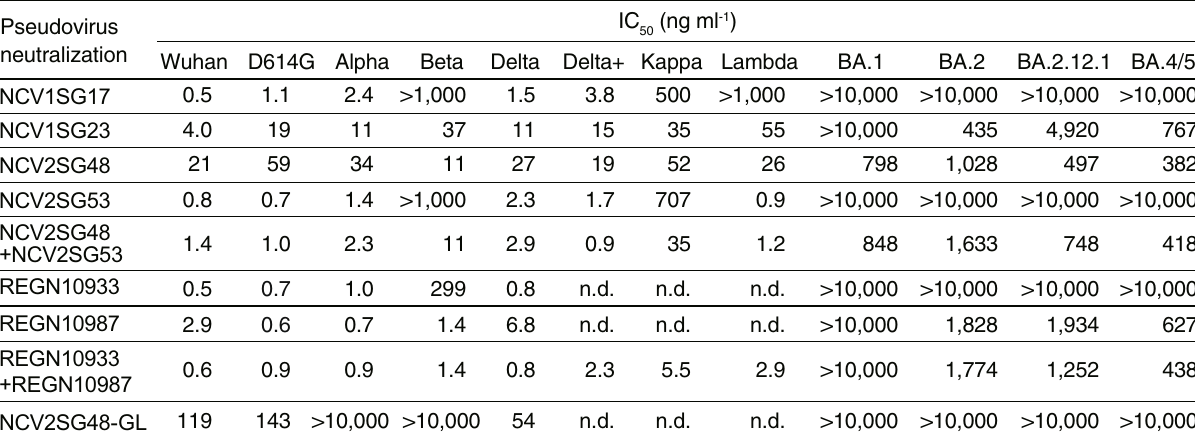
Fig. 2 Broadly neutralizing potency of mAbs against SARS-CoV-2 variants. a Dose-response analysis of the neutralization by each mAb NCV1SG17, NCV1SG23, NCV2SG48, NCV2SG53, REGN10933, and REGN10987 on indicated variants of SARS-CoV-2 pseudovirus. The horizontal dotted line on each graph indicates 50% neutralization. Data are mean ± SEM of technical replicates from 2 to 3 independent experiments. b The IC 50 neutralization values of each and the mixture of mAbs against indicated pseudoviruses of the SARS-CoV-2 variant. NCV2SG48-GL, germline revertant of